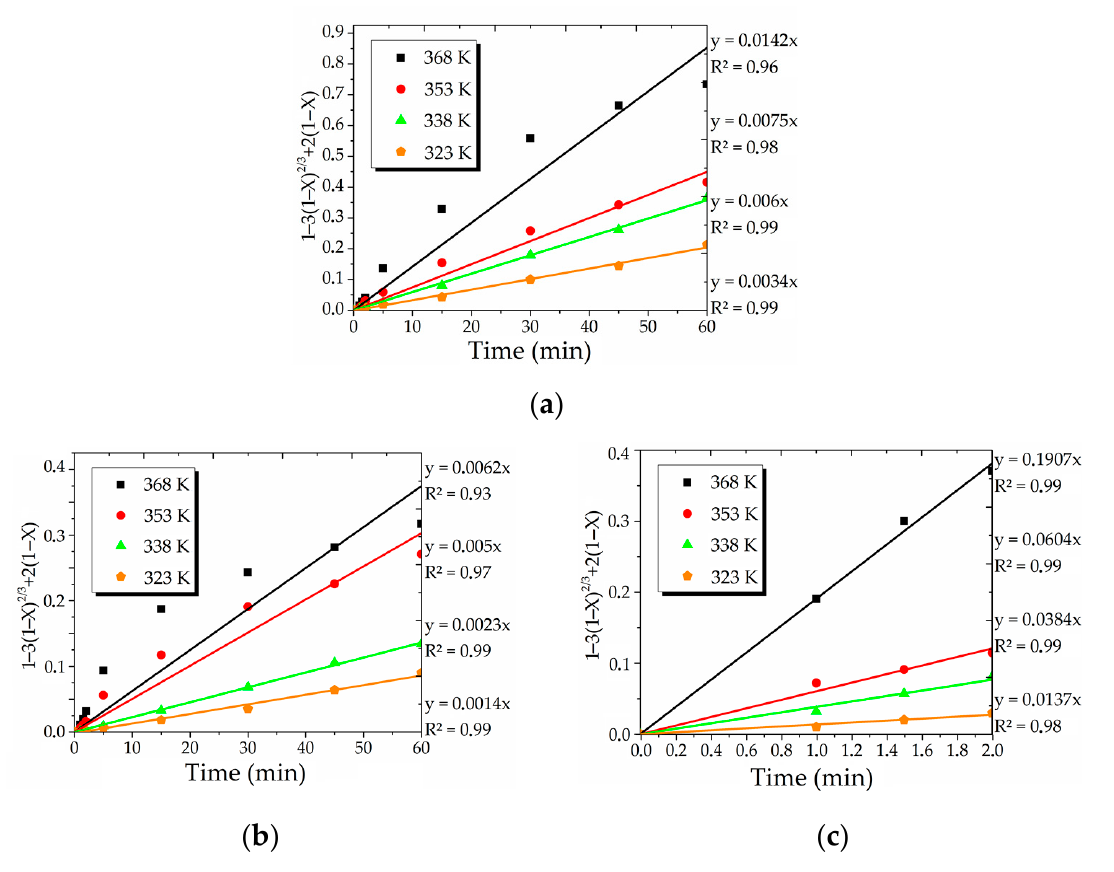
Figure 10. The linear relationship between 1 − 3(1 − X) 2/3 + 2(1 − X) = k· τ and treatment time of Cu 12 As 4 S 13 ( a ), CuFeS 2 ( b ) and ZnS ( c ) at various temperatures. Table 4. The reaction orders with respect to HNO 3 concentration, Fe (III) ions concentration and the amount of FeS 2 additive at Cu 12 As 4 S 13 , CuFeS 2 and ZnS treatment. Cu 12 As 4 S